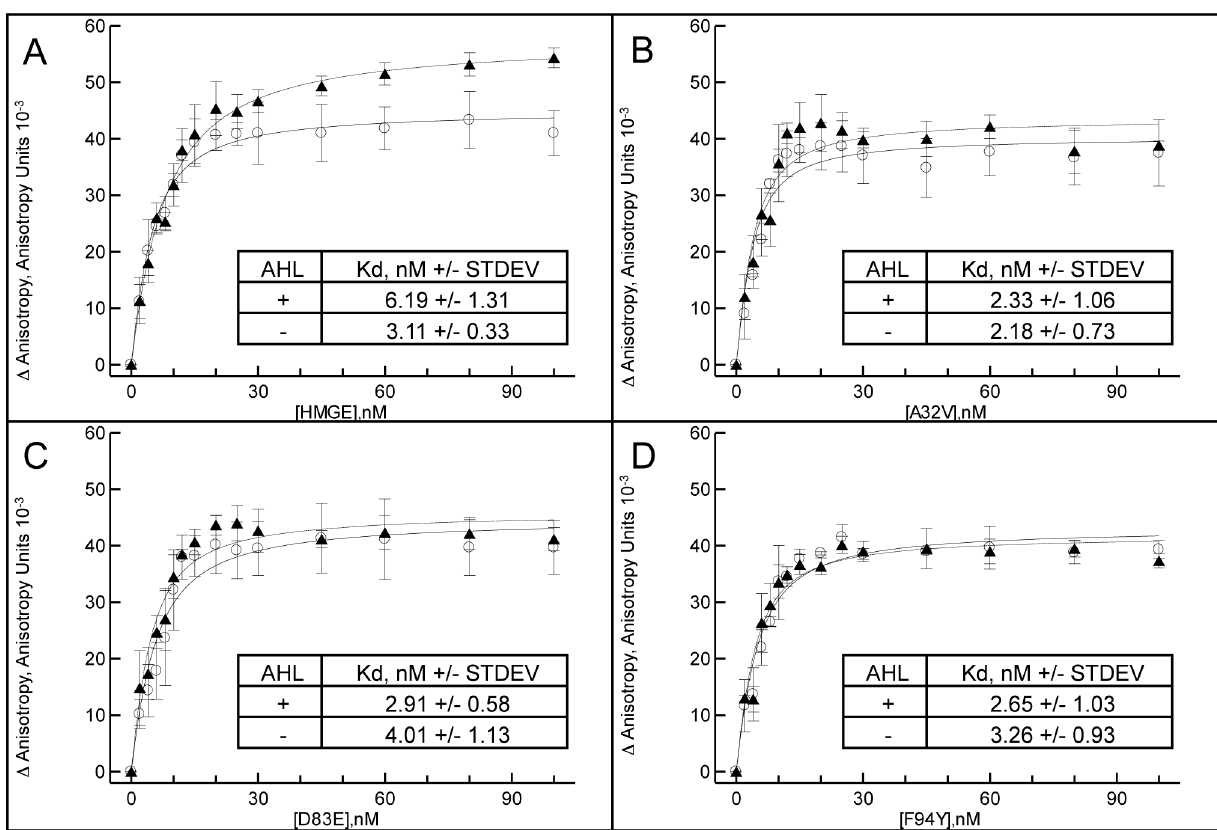
Figure 4. Invitro relative binding affinities of HMGE and EsaR * variants. Various protein concentrations (0–100 nM) of A) HMGE, B) A32V, C) D83E, D) F94Y were incubated with 3 nM T-esabox (dsDNA concentration) for 20 min at 25 u C in the presence (triangles) and absence (circles) of 1 m M AHL. Fluorescence anisotropy was measured with a Tecan F200 Pro fluorometer with a G factor of 1 and excitation and emission wavelengths of 540 and 590 nm, respectively. Background anisotropy was subtracted and the resulting data were used to generate a fit curve and calculate the apparent Kd. Duplicate samples were analyzed from experiments performed in triplicate. Average of and standard deviation across three experiments for each protein is shown.